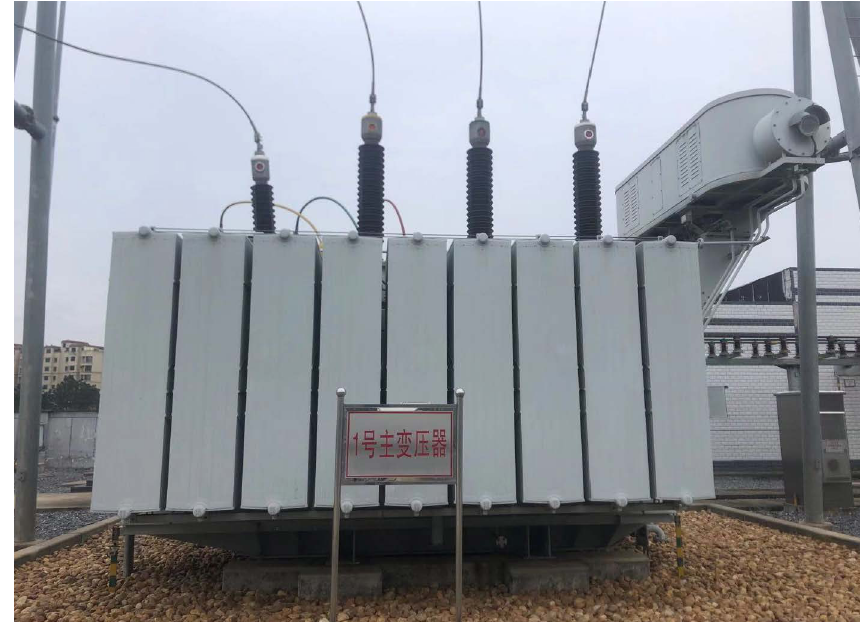
Figure 4. A power transformer with mineral oil as insulating